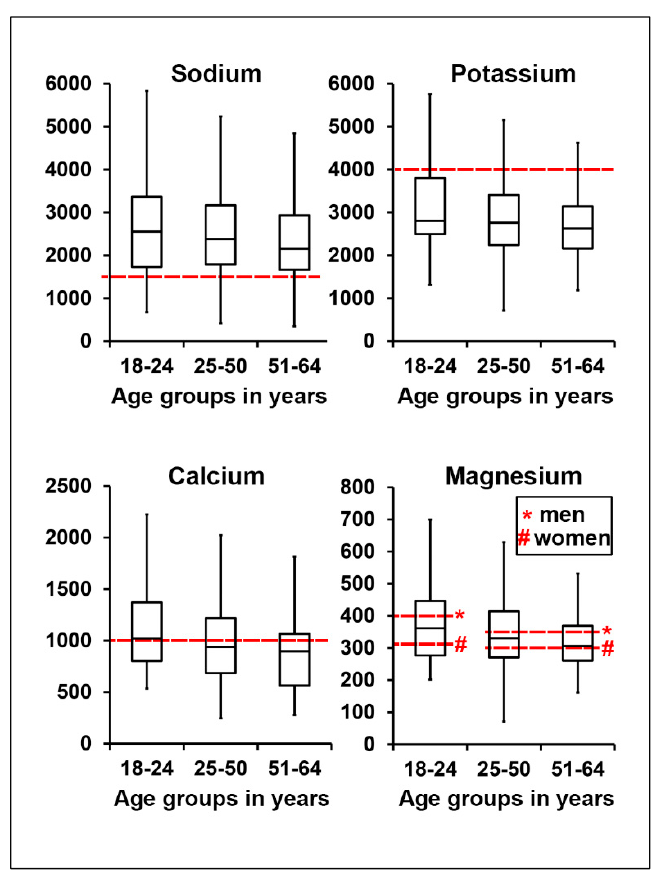
Figure 2. Median intake levels of sodium, potassium, calcium and magnesium in different age groups in mg/day. Red dashed lines depict recommended intake levels for each electrolyte. For magnesium, red dashed lines depict reference values for different gender groups: men (asterisk *) and women (hash sign #) accordingly.